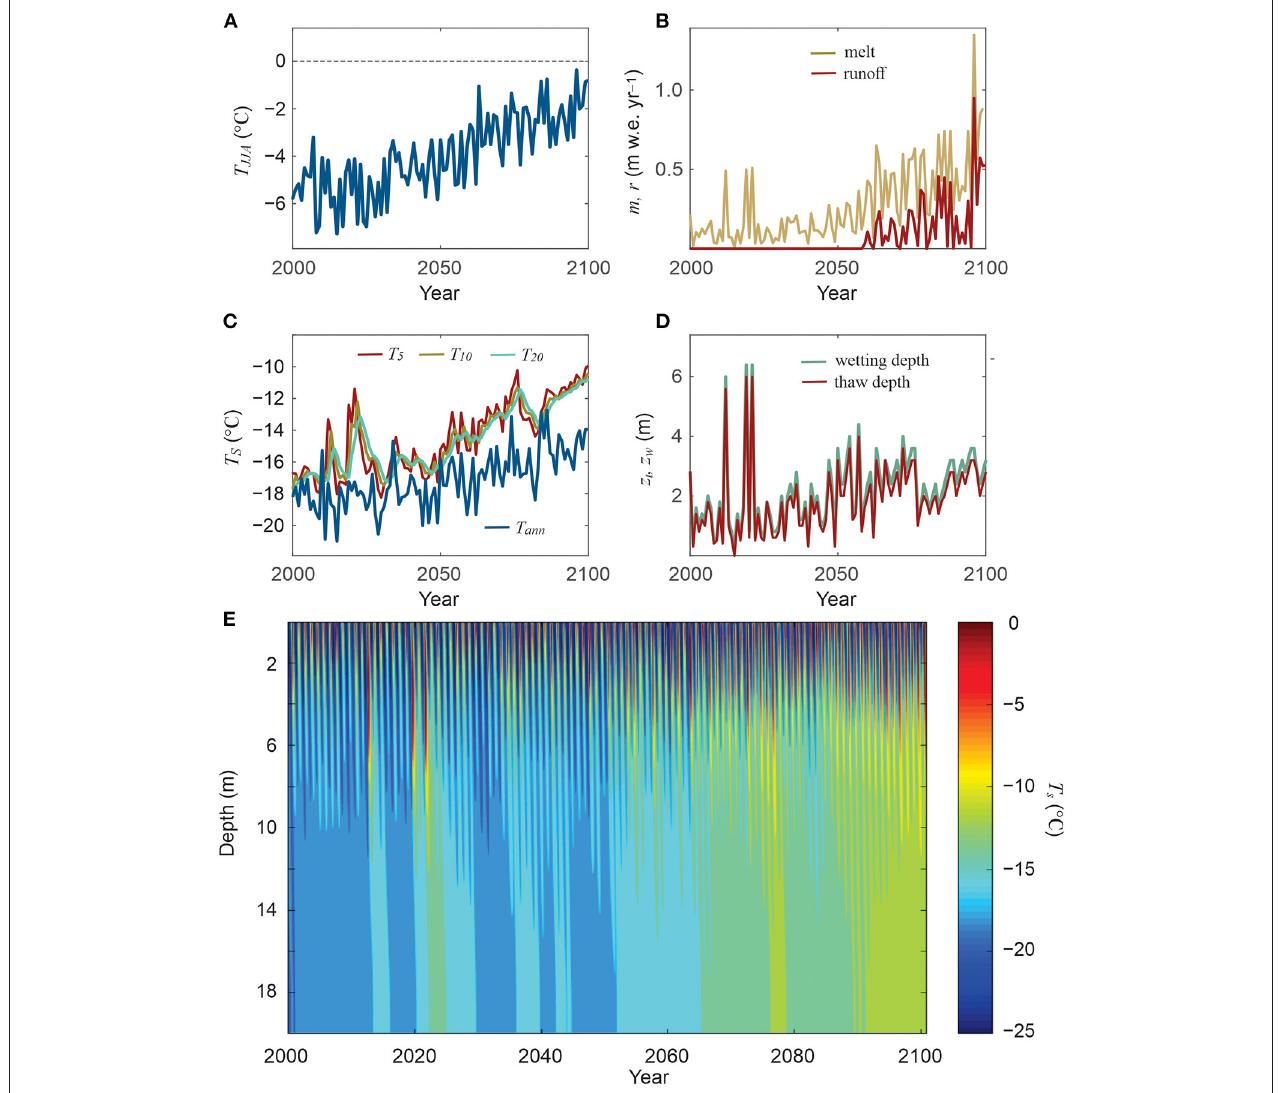
FIGURE 4 | Modelled firn evolution at DYE-2, Greenland, 2000–2100, using ERA5 climate forcing from 2020 to 2020 and with a warming trend of 0.05 ◦ C yr − 1 for 2020–2100. (A) Mean summer air temperature. (B) Annual surface melt and runoff. (C) Mean annual snow/firn temperatures at the surface and at 5-, 10-, and 20-m depth. (D) Maximum annual thaw and meltwater infiltration depths. (E) Daily mean temperatures in the 20-m firn column from 2000 to